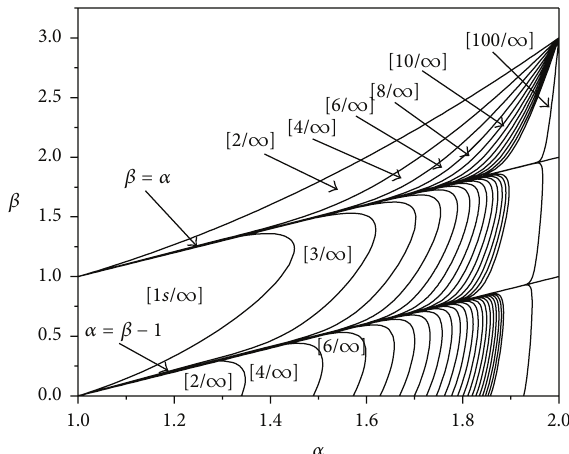
Figure 8: Region [ 𝑓( odd )/∞ ] showing the subphases [ 𝑛/∞ ], 𝑛 = 1𝑠, 3, 5, 7, 9, . . . .